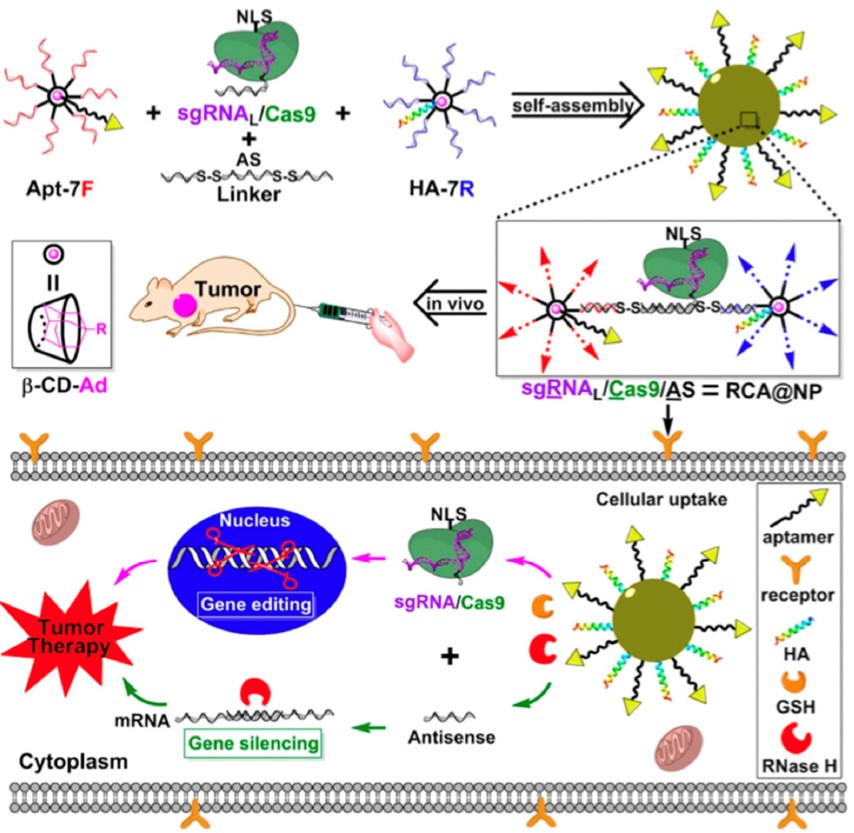
Figure 6. Model of DNA nanostructure that co-deliver gene editing and gene silencing to the cell. DNA nanostructures base-paired with the sgRNA/Cas9 and covalently crosslinked with antisense strands enter the cell via endocytosis. Antisense strands are released by RNase H and bind to mes- senger RNA for gene silencing. The CRISPR complex enters the nucleus to perform gene editing while the multifunctional nanocarrier provides synergistic tumor therapy. 7F or 7R: DNA oligonu- cleotides covalently crosslinked by beta-CD. Reproduced with permission from [108] Copyright © 2022 American Chemical Society.